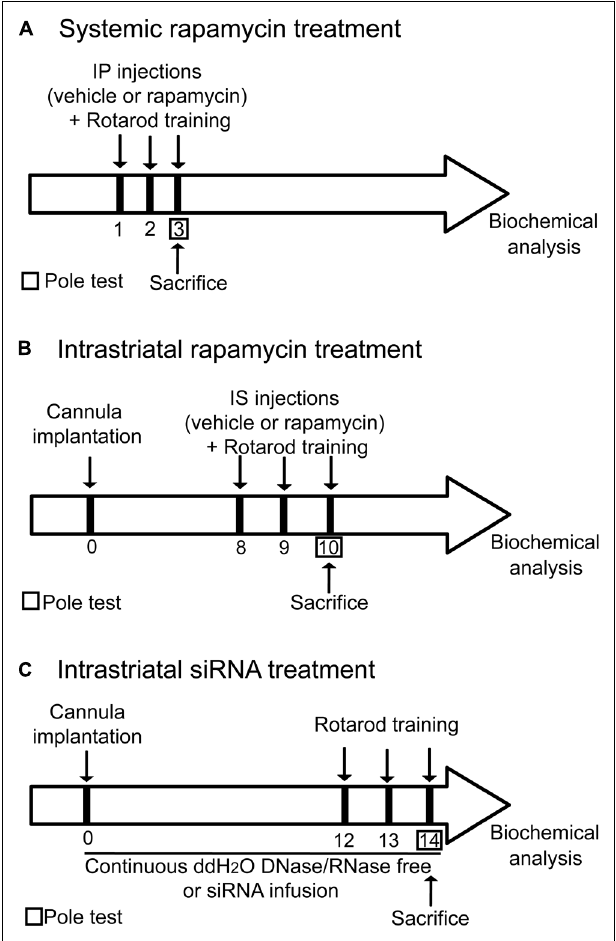
FIGURE 1 | Illustration depicting the experimental design. All animals were subjected to the same handling treatment before the experiments. (A) For systemic treatment, mice were injected systemically with vehicle (DMSO) or rapamycin 15 min prior each rotarod training session. (B) For intrastriatal treatment, a bilateral guide cannula was implanted in the dorsal striatum of mice. After the surgery, seven days of recovery were given to the mice before starting the experiments. 15 min prior the first trial of each rotarod training days, injection of vehicle (DMSO) or rapamycin was delivered into the dorsal striatum of both hemispheres. (C) For intrastriatal siRNA infusion, a bilateral connector cannula was installed into the dorsal striatum.Two osmotic mini-pumps were surgically placed subcutaneously on each side of the scapulae and connected to the cannula via a plastic connector. Mice were receiving for 14 consecutive days a continuous intrastriatal infusion with either distillated/deionized water DNase/RNase free or mTOR siRNA. Mice were trained on the rotarod on the 12th, 13th, and 14th days of treatment.